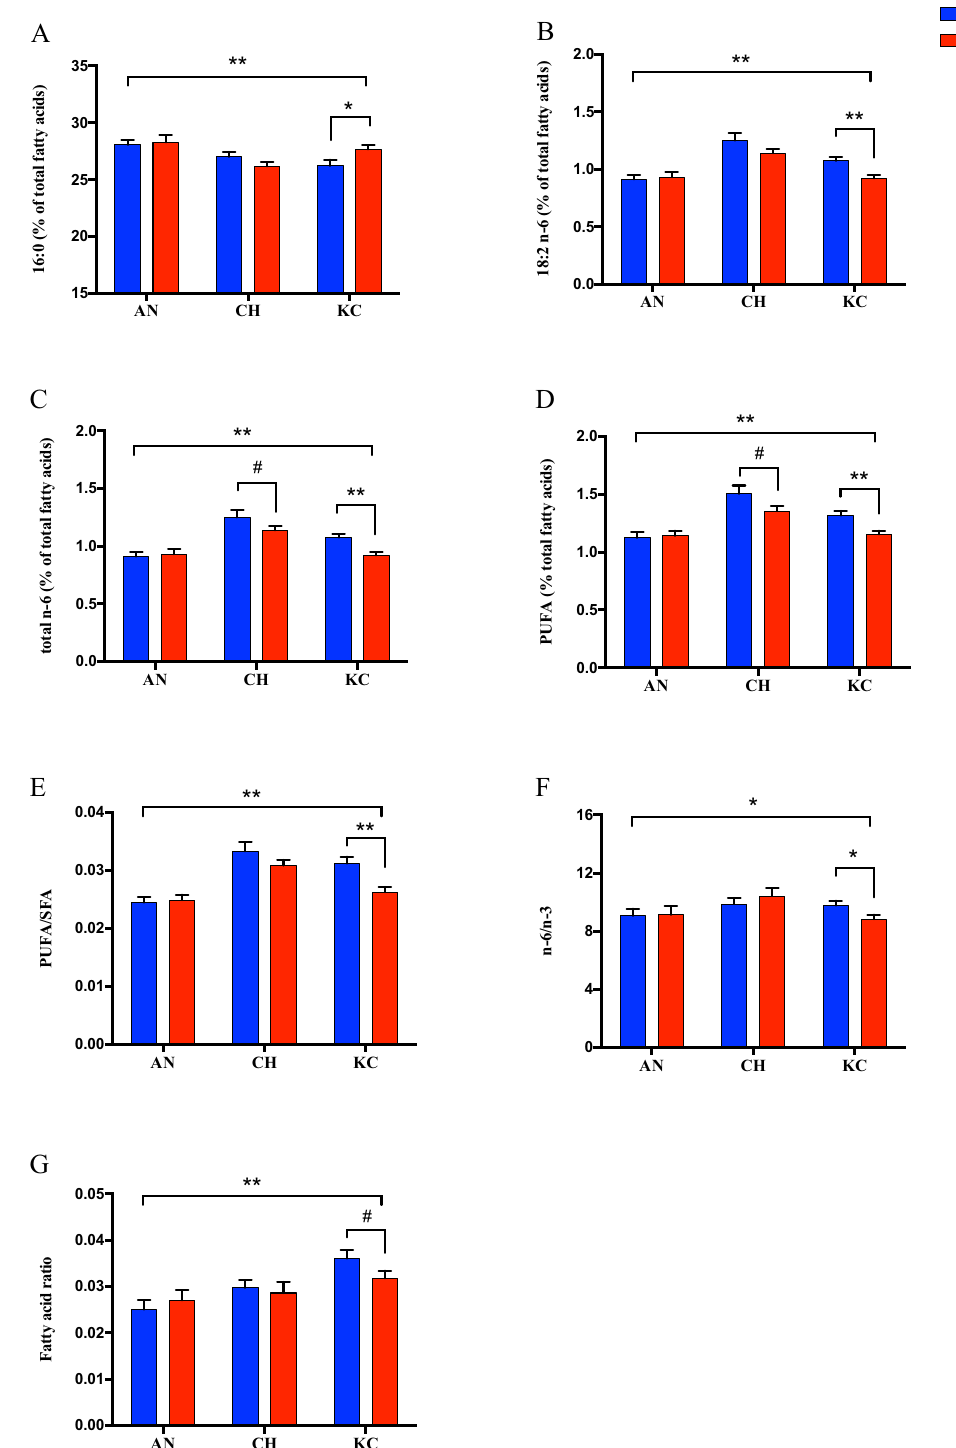
Figure 1. Differential abundant FAs between H-RFI and L-RFI steers as analyzed for each cattle breed respectively. Significance was indicated as follows: ** p < 0.01; *0.01 ≤ p < 0.05; #0.05 ≤ p <